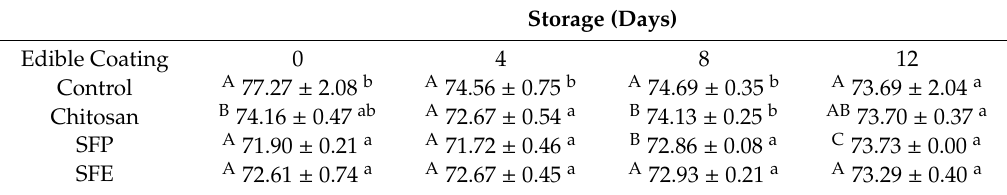
Table 3. Moisture content (%) of Atlantic horse mackerel burgers coated with di ff erent film formulations (control without coating film, chitosan, sea fennel plant (SFP) incorporated in a chitosan-based film and sea fennel extract (SFE) incorporated in a chitosan-based film) and stored at 4 ◦ C for 12 days. Storage (Days) Edible Coating 0 4 8 12 Control A 77.27 ± 2.08 b A 74.56 ± 0.75 b A 74.69 ± 0.35 b A 73.69 ± 2.04 a Chitosan B 74.16 ± 0.47 ab A 72.67 ± 0.54 a B 74.13 ± 0.25 b AB 73.70 ± 0.37 a SFP A 71.90 ± 0.21 a A 71.72 ± 0.46 a B 72.86 ± 0.08 a C 73.73 ± 0.00 a SFE A 72.61 ± 0.74 a A 72.67 ± 0.45 a A 72.93 ± 0.21 a A 73.29 ± 0.40 a Values (mean ± standard deviation, n = 3) followed by a di ff erent uppercase letter in the same row are significantly di ff erent ( p < 0.05). Values (mean ± standard deviation, n = 3) followed by a di ff erent lowercase letter in the same column are significantly di ff erent ( p <